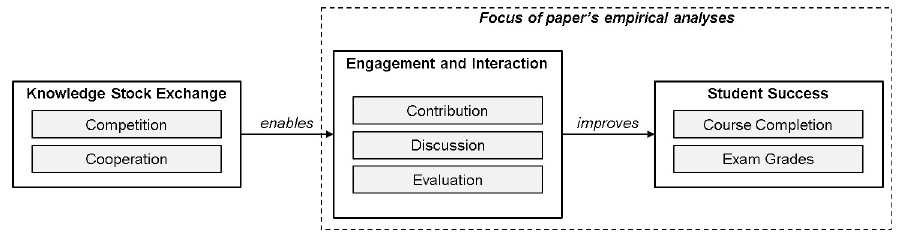
Fig 1. Research model.